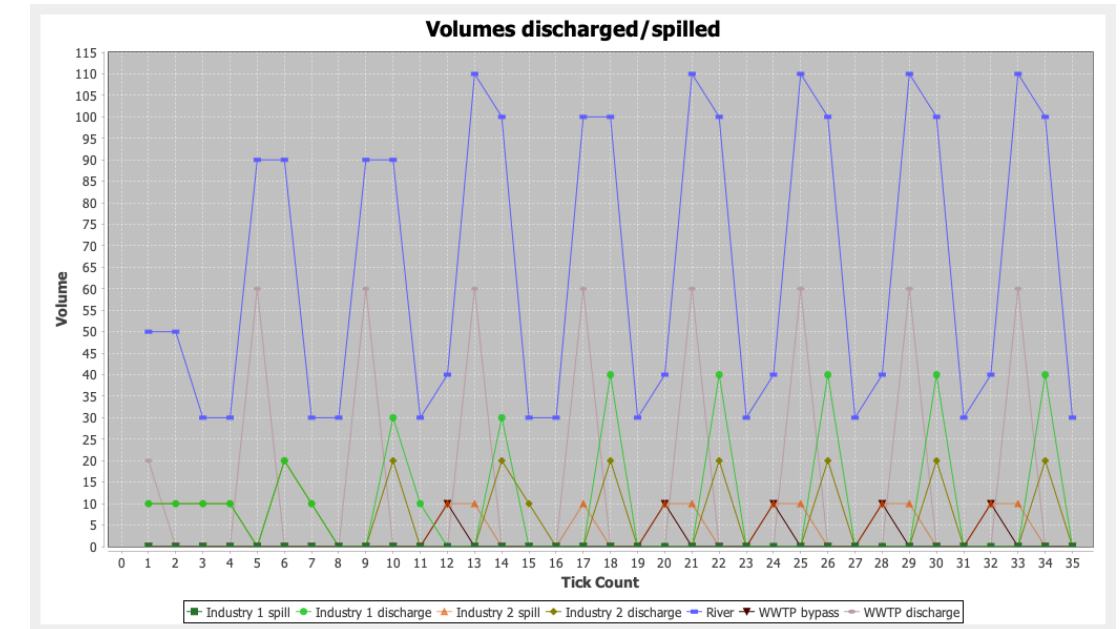
Figure 6. The figure shows an execution with one WWTP with an incoming water tank of 60 volume units and two industries (storage tanks with 40 and 20 volume units of capacity each). No rainfall.